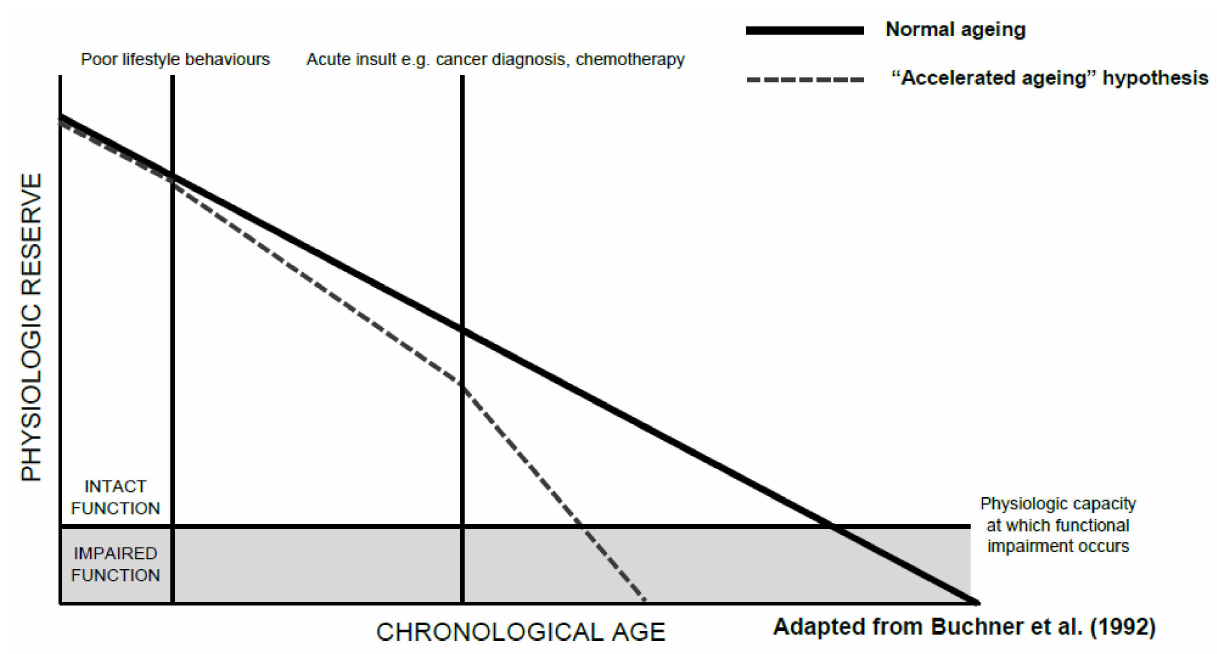
Figure 1. An “Accelerated Ageing” model of functional decline [11].